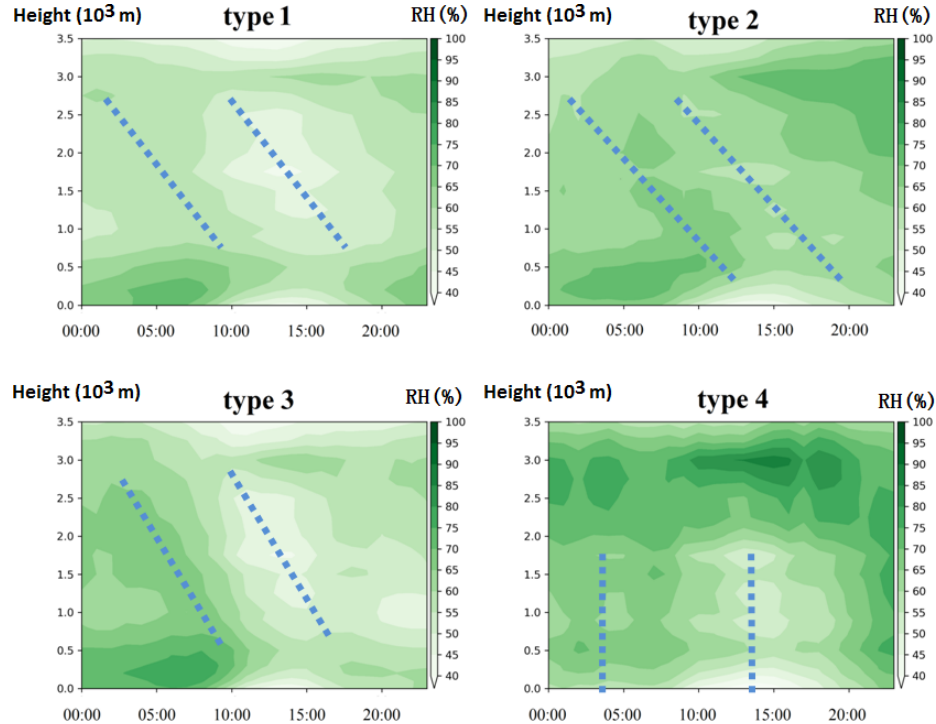
Figure 6. Average characteristics of the relative humidity (RH) field in the boundary layer under four pollution types in the Beijing observa- tory (39.93 ◦ N, 116.28 ◦ E) (shadow represents relative humidity, unit: %; x axis is Beijing time from 00:00 to 23:00CST; y axis is height, unit: